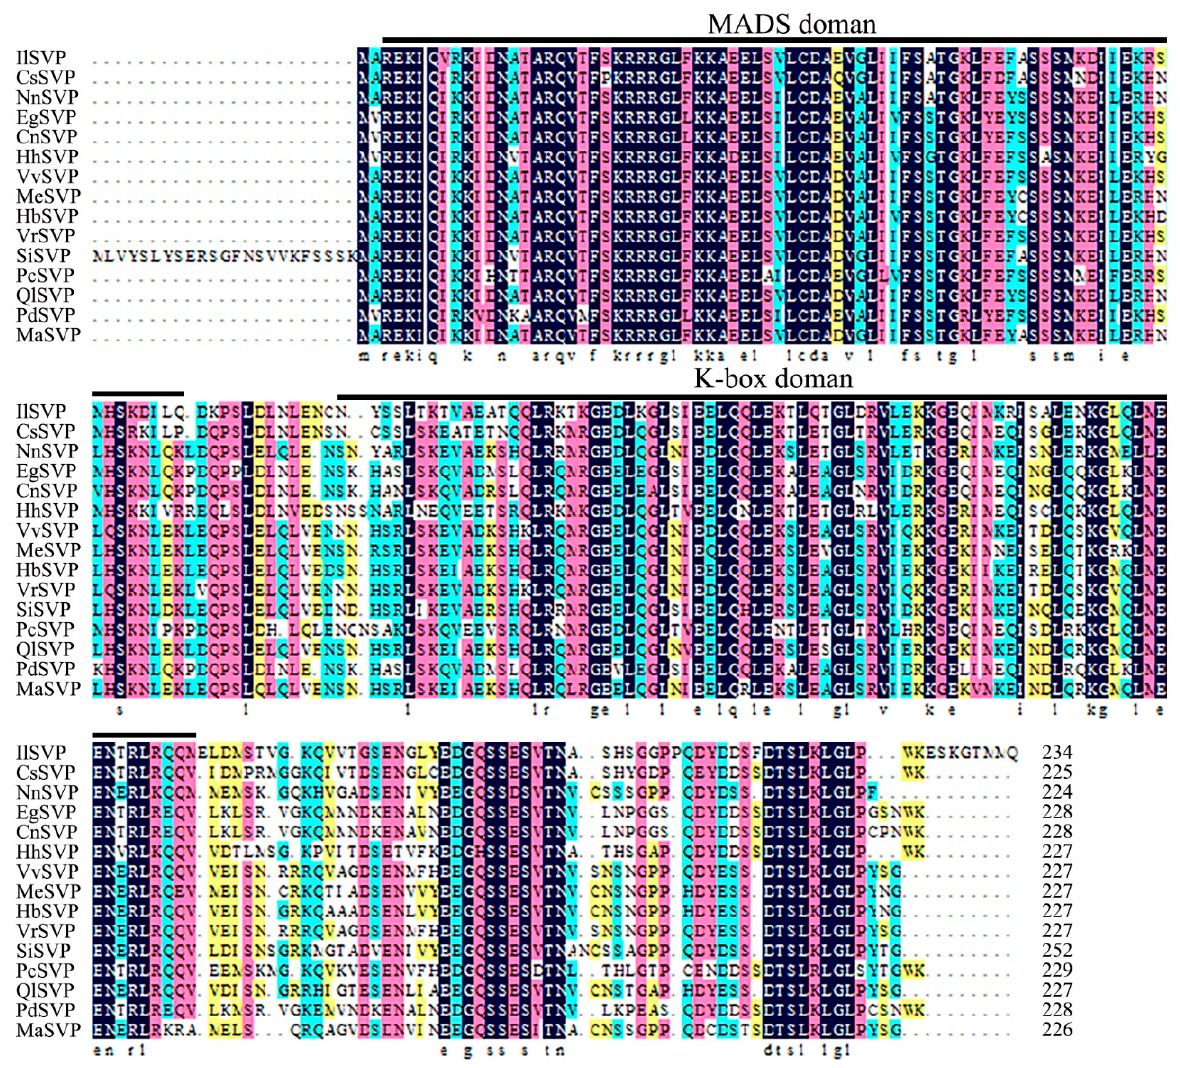
Figure 3. Sequence alignment of Il SVP proteins from different species. Il SVP: Iris laevigata (ON398431); Cs SVP: Crocus sativus (QIH12017.1); NnSVP: Nelumbo nucifera (XP_010254525.1); EgSVP: Elaeis guineensis (XP_010942683.1); CnSVP: Cocos nucifera (EHA8591139.1); HhSVP: